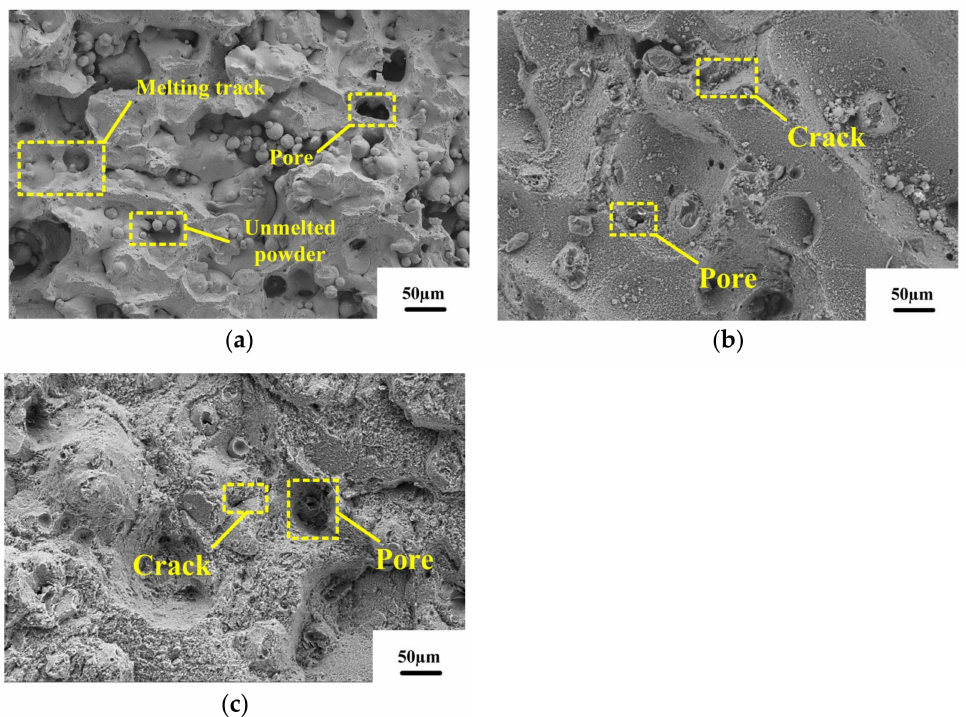
Figure 11. Tensile specimen fracture microscopic morphology: ( a ) deposited; ( b ) 300 ◦ C/1 h; ( c ) 535 ◦ C/1 h + 175 ◦ C/2